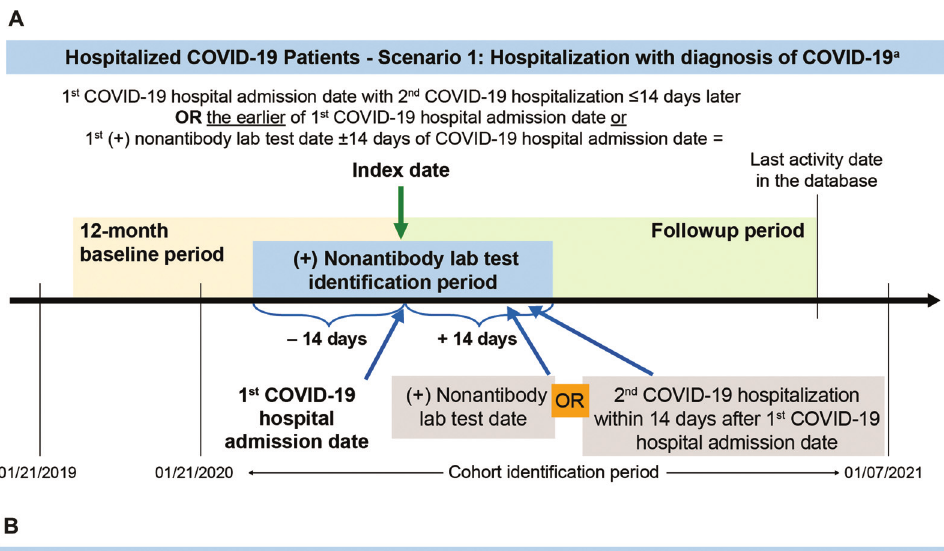
TH Open Vol. 6 No. 4/2022 © 2022. The